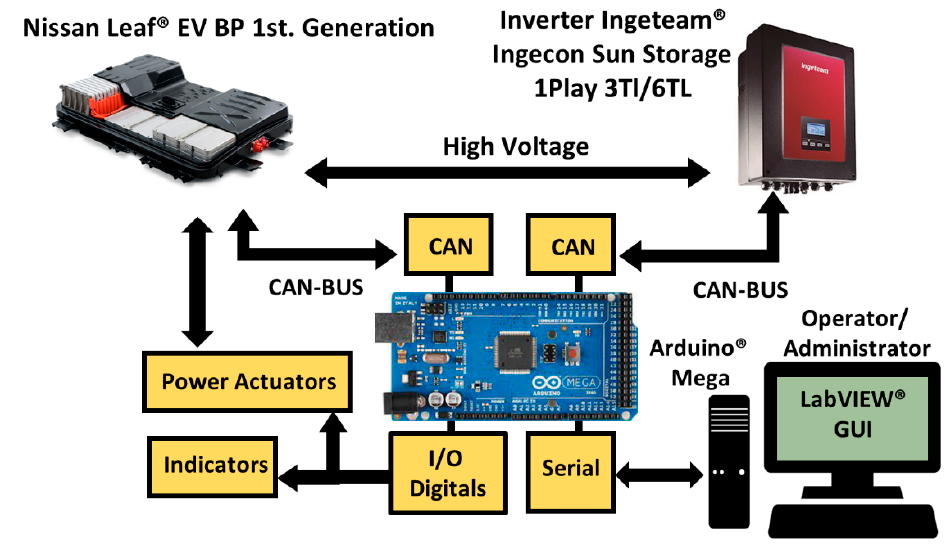
Figure 3. Experimental setup for the EV BP monitoring.